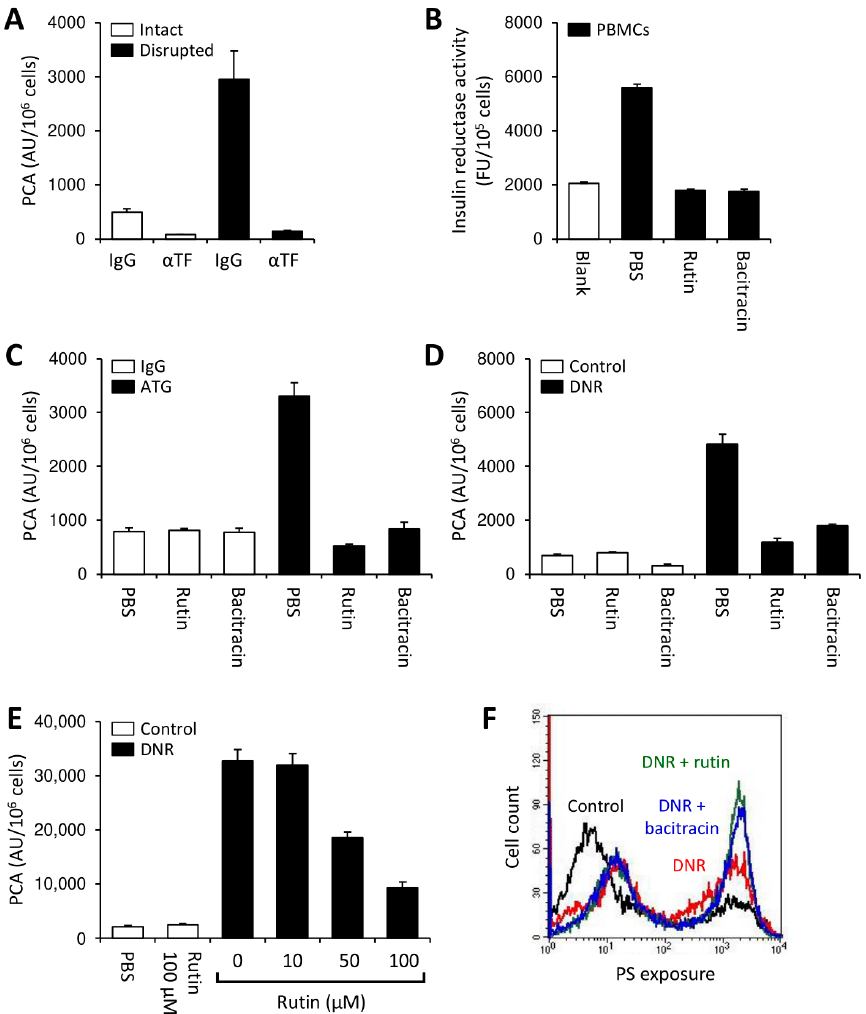
Figure 5. Activation of cryptic TF on PBMCs from a patient with acute myeloid leukemia (AML) is prevented by rutin and bacitracin. Whole-blood PBMCs were isolated from a patient with newly diagnosed AML and analyzed for PCA both before and after repeated freeze–thawing ( A ) and for insulin reductase activity in the presence or absence of 100 µM rutin or 5 mM bacitracin ( B ). ( C )